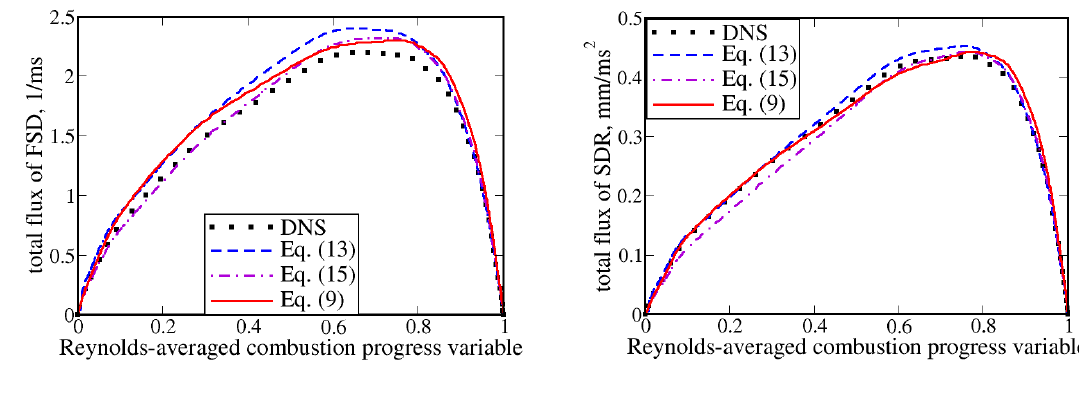
Figure 2. Total axial fluxes of ( a ) FSD Σ and ( b ) SDR χ . Case M.